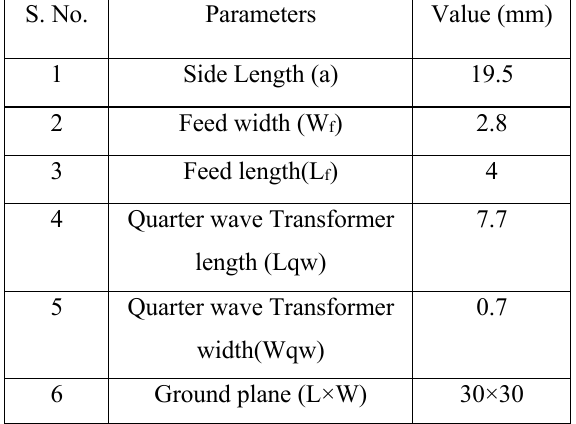
Table 1: Design parameters of patch antenna S.